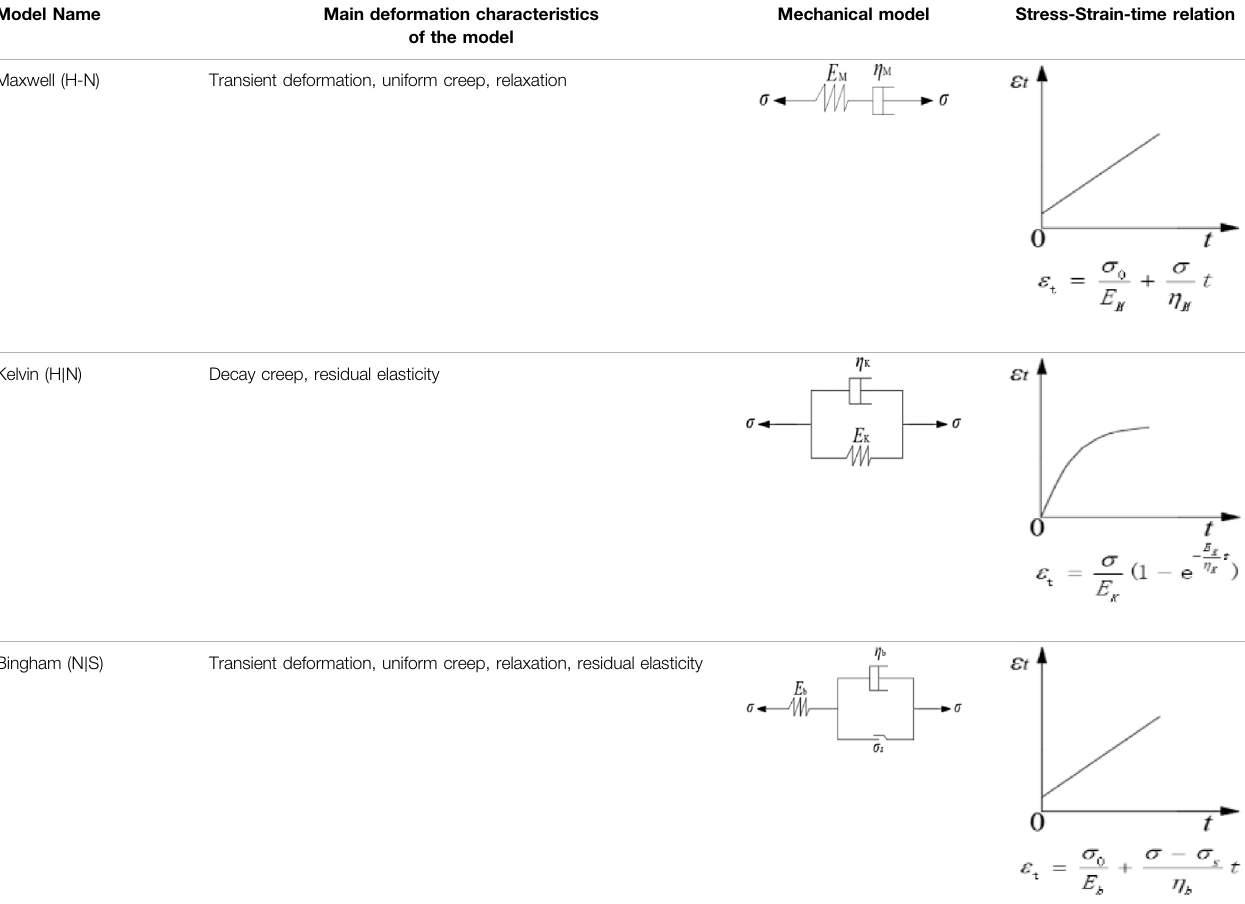
TABLE 1 | Rheological model and main deformation